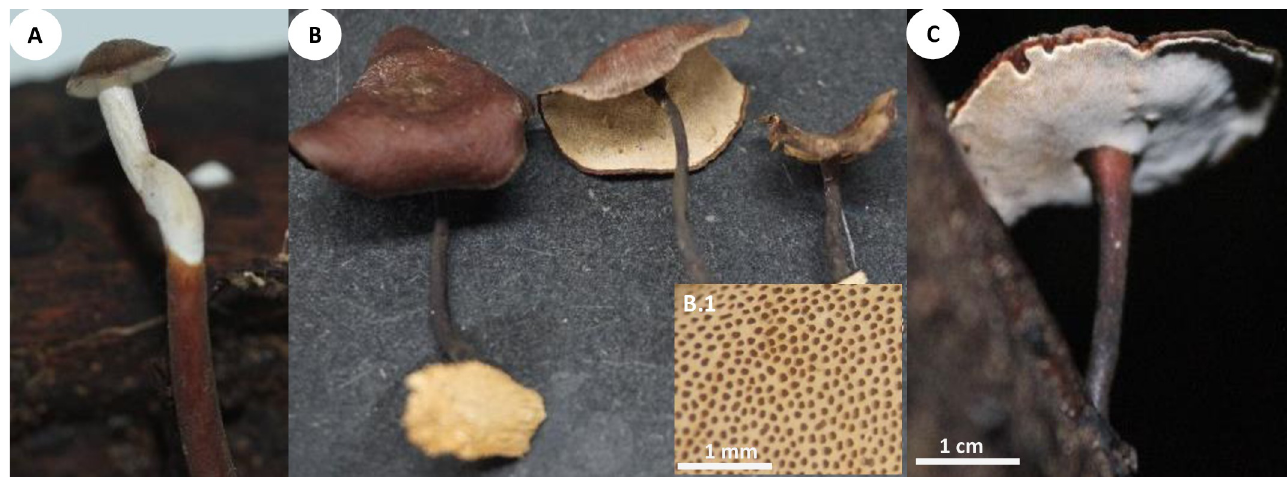
Fig 5. Basidiomata of Atroporus tagaeri . A. Young basidiome with ongoing melanization of stipe. B. Dried basidiomata with fully melanized stipes and shrunken pileus. B.1 Pore layer. C. Fresh basidiome.